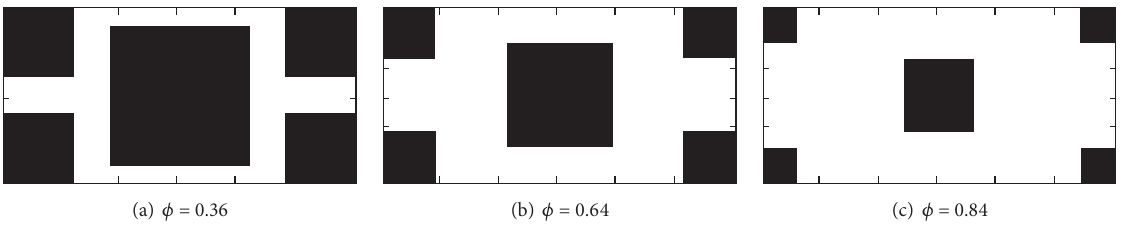
Figure 7: Unit cell for staggered-array of uniform shapes (i.e., squares), represented by cells with periodic boundaries and porosity 𝜙 . For all staggered-array examples: 𝑎/𝑏 = 1 and 𝐿 𝑎 /𝐿 𝑏 = 1 (refer to Figure 8 for dimension details).